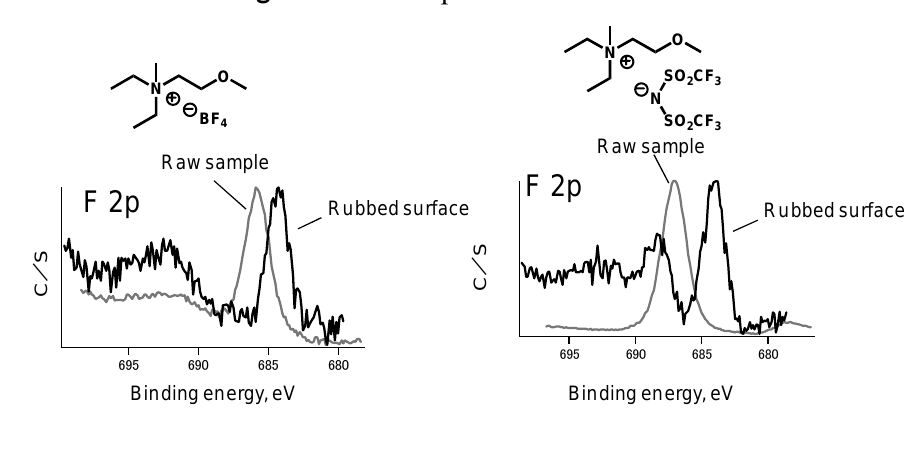
Figure 14. XPS spectra of rubbed surface.